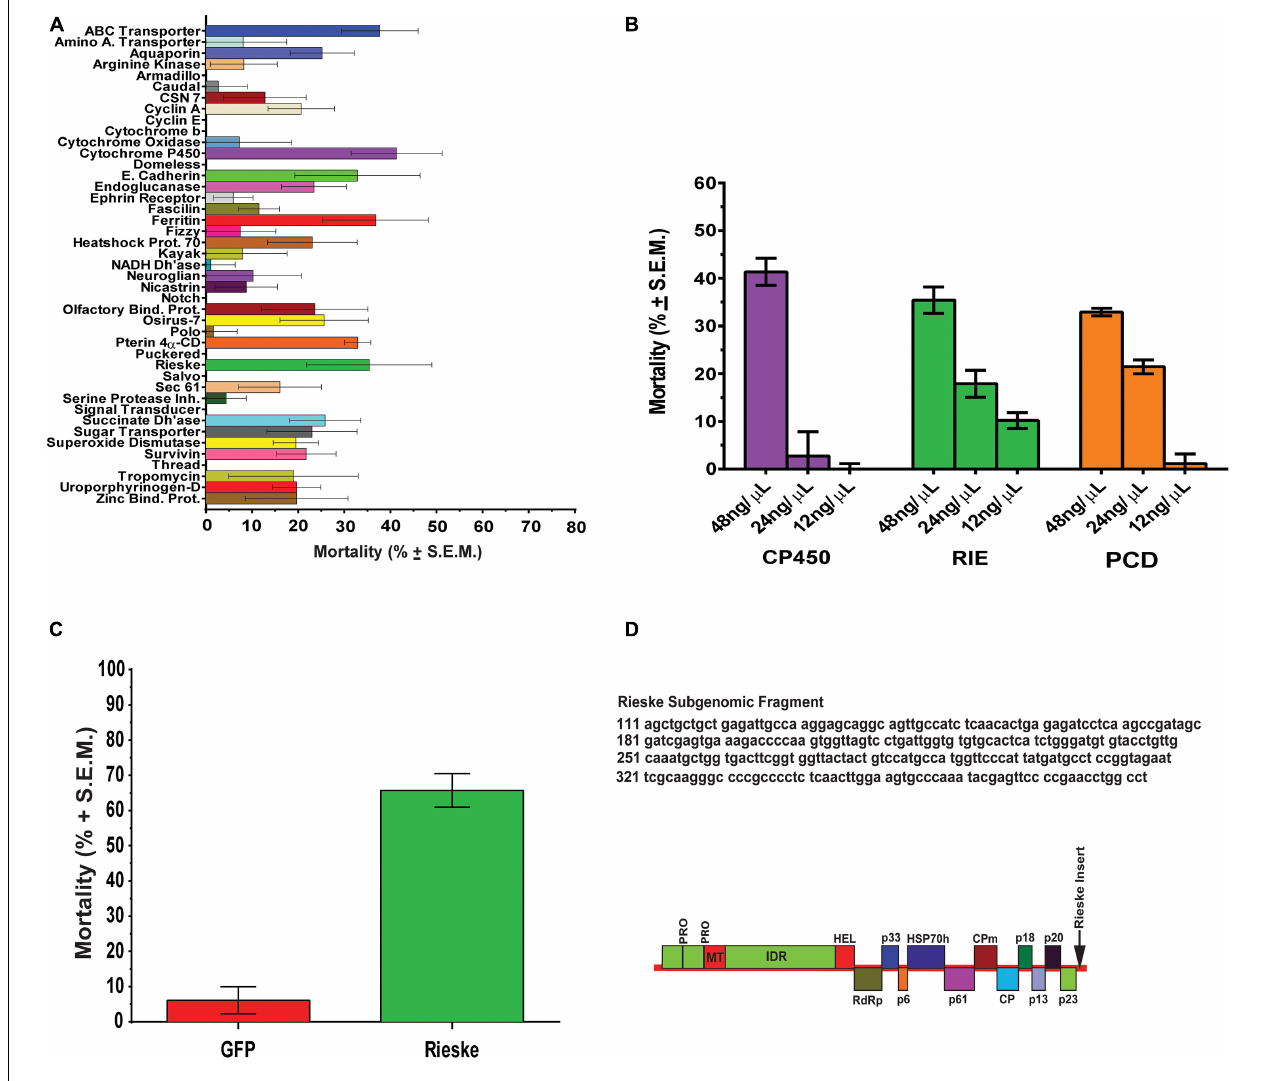
FIGURE 1 | RNA interference studies. (A) Mortality of D. citri after feeding on dsRNA (48 ng/ µ L) of different target genes. The results are expressed as mean mortalities (%) corrected with mortalities observed by feeding on diet without dsRNA (control) of 6 determinations ± S.E.M. Twenty dsRNAs out of 43 tested caused significant mortalities above control diets. (B) Dose response of genes ( CP450 , RIE, and PCD ) that were most significantly down regulated by a single concentration of dsRNA (48 ng/ µ L) in (A) using concentrations of 48, 24, and 12 ng/ µ l, respectively. (C) Effect of engineered CTV- RIE and CTV- gfp on D. citri feeding on C. macrophylla infected leaves using single leaf bioassays. The infected C. macrophylla leaves expressed RIE (Rieske) and gfp subgenomic dsRNAs of Green Fluorescent Protein of A. victoria GFP gene sequence that does not share sequence identity with D. citri genes. Mortalities are expressed as means of 6 determination ± SEM and were corrected with mortalities observed by feeding D. citri on leaves infected with CTV-wt. (D) CTV viral amplicon used to infect C. macrophylla is shown including the RIE subgenomic sequence that was cloned at the p23 locus in the 3 (cid:48) -NTR (non-translated region,